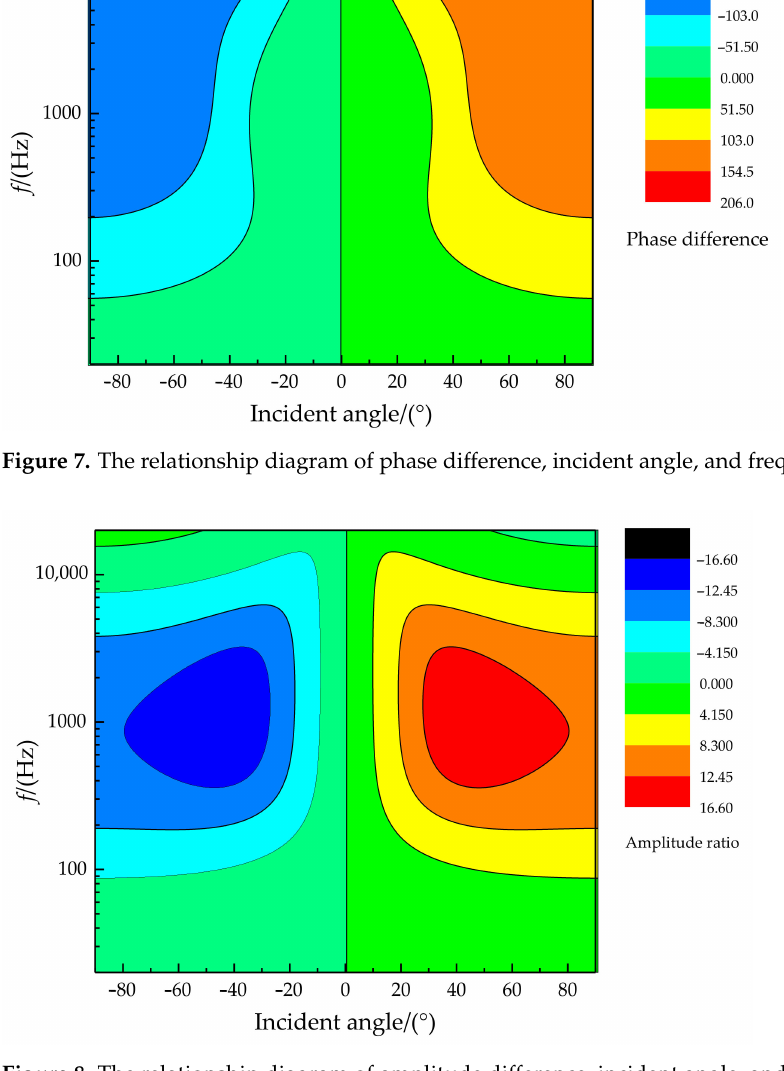
Figure 8. The relationship diagram of amplitude difference, incident angle, and frequency.